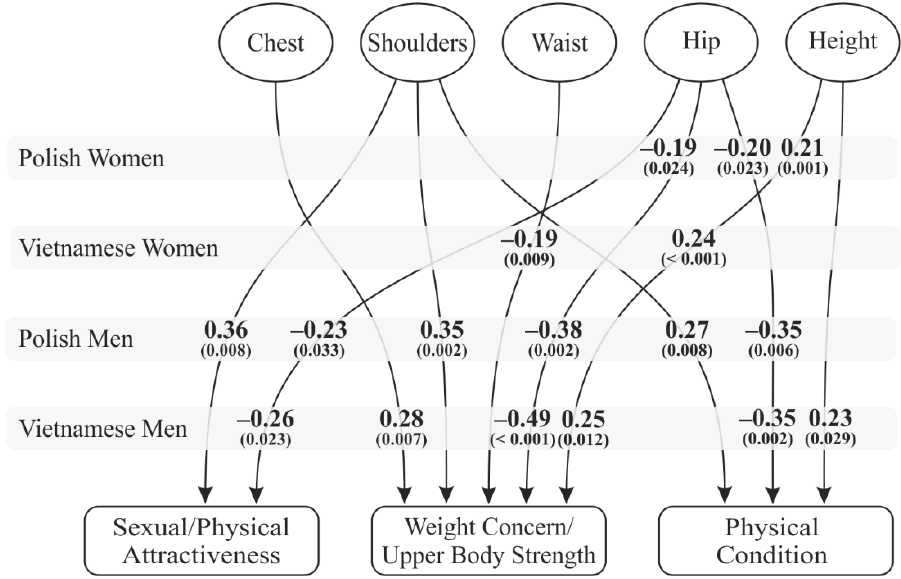
Figure 1. Body measurements as predictors of body esteem.